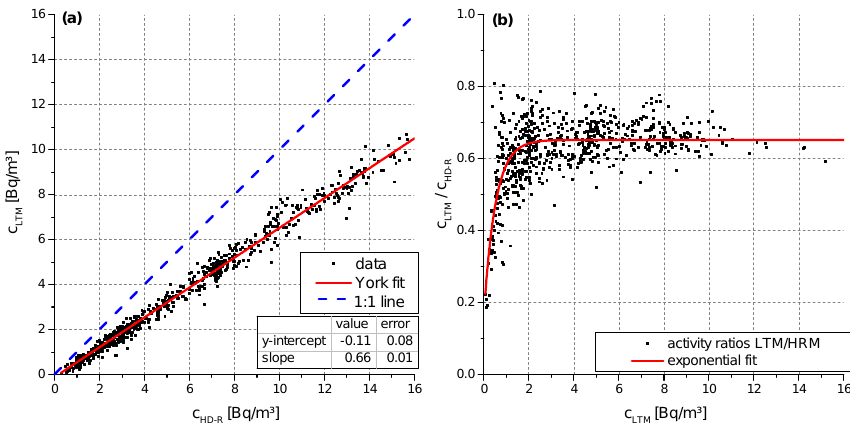
Figure 1. (a) Correlation of the 214 Po activity concentration measured with the line test monitor (LTM) sampling via a 200m intake line vs. that measured with the Heidelberg routine monitor (HD-R). The red line is a least squares fit (York et al., 2004) through the data yielding a slope of 0.66; the dashed blue line shows the 1:1 relation. (b) Activity concentration ratio of the LTM and the HD-R monitor plotted vs. the activity concentration measured with the LTM. The red line is an exponential fit through the data according to Eq. (1).